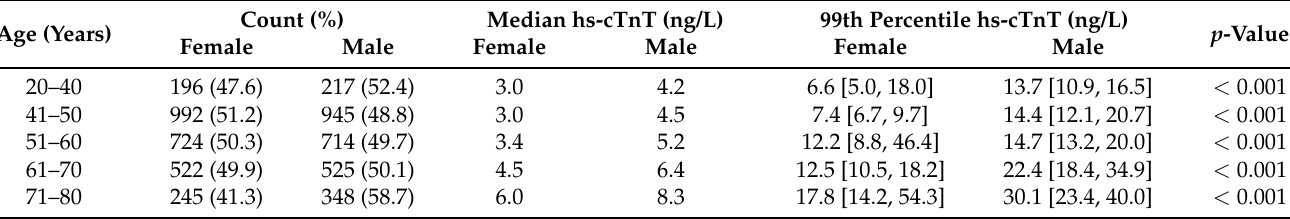
Figure 2. Age-specific floating median (circles) and 99th percentile (squares) hs-cTnT values in females (red) and males (blue). The ranges of 97th–99.4th hs-cTnT percentiles (smoothed with a window size of +/ − 10 years per point) are highlighted in light red (females) and light blue (males). Hs-cTnT: highly sensitive troponin T. Table 2. Age distribution, corresponding number of participants, age-adjusted median, and 99th percentile values of hs-cTnT (95% confidence interval) per group, divided by sex in a cardiac-healthy population in study cohort 1. Hs-cTnT: highly sensitive cardiac troponin